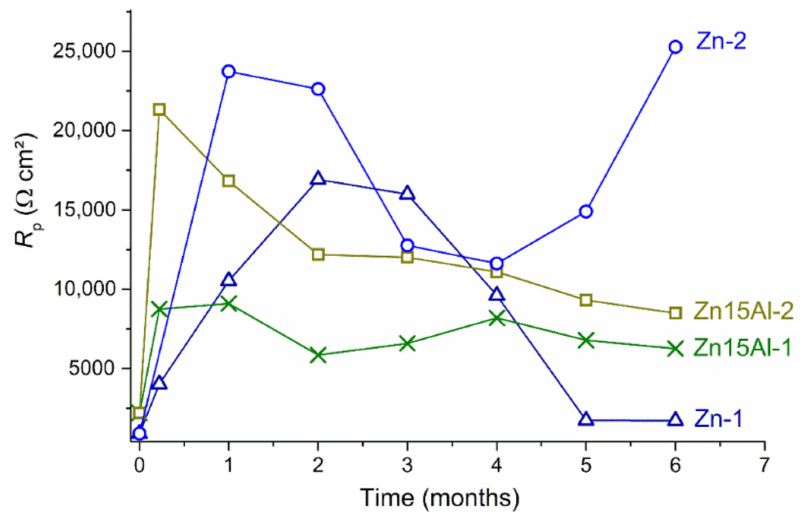
Figure 6. Evolution over time of the polarization resistance of the coated electrodes during the 6-month galvanic corrosion experiment. LPR measurements were performed with the electrode at OCP, i.e., disconnected from its paired bare steel